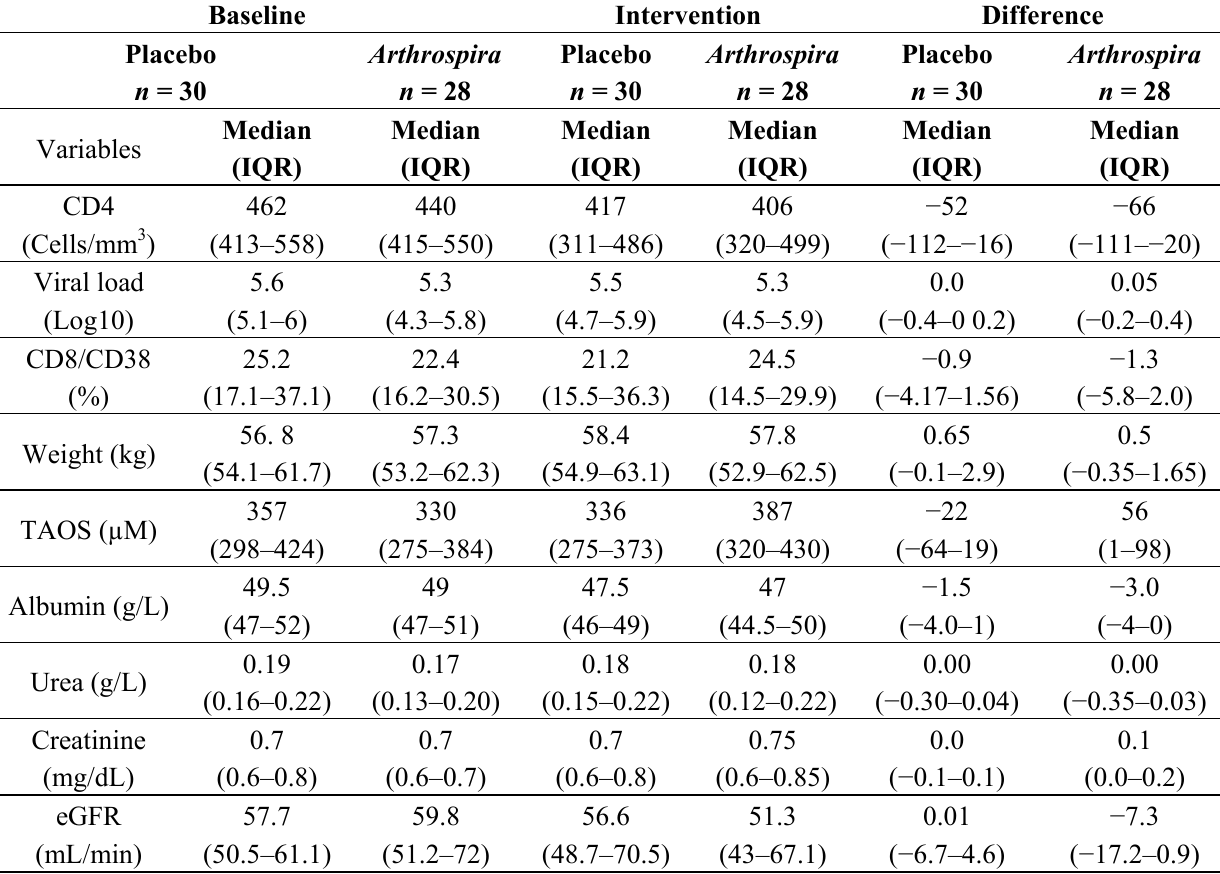
Table 2. Study variables. TAOS, total antioxidant status in blood serum.